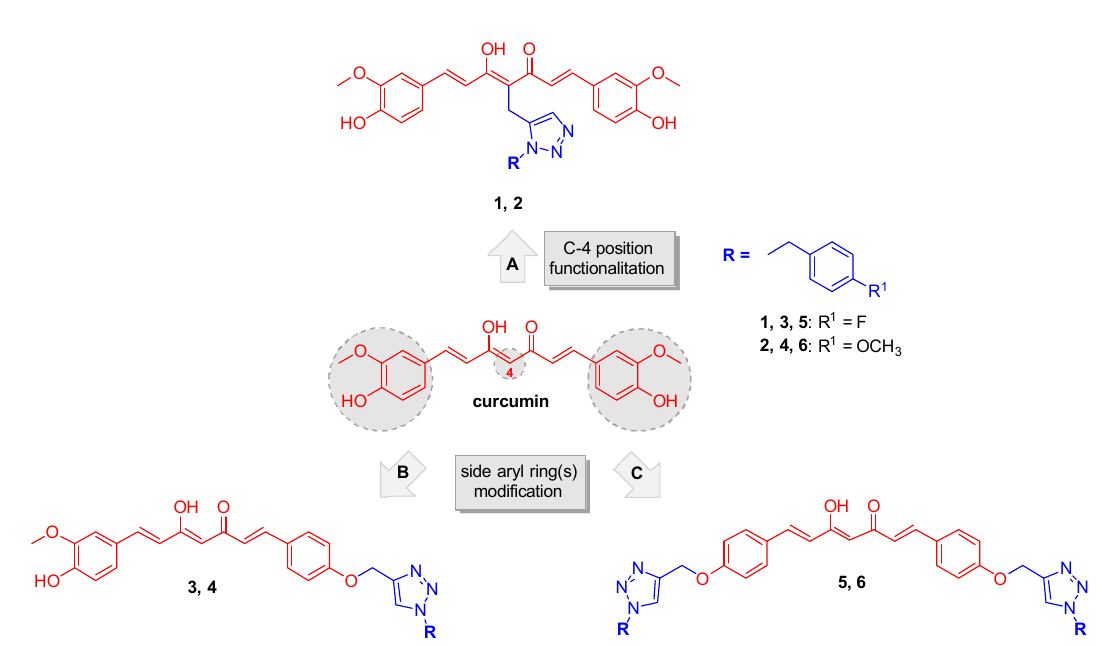
Figure 1. Chemical structure of curcumin and design strategy for obtaining analogs 1 – 6.